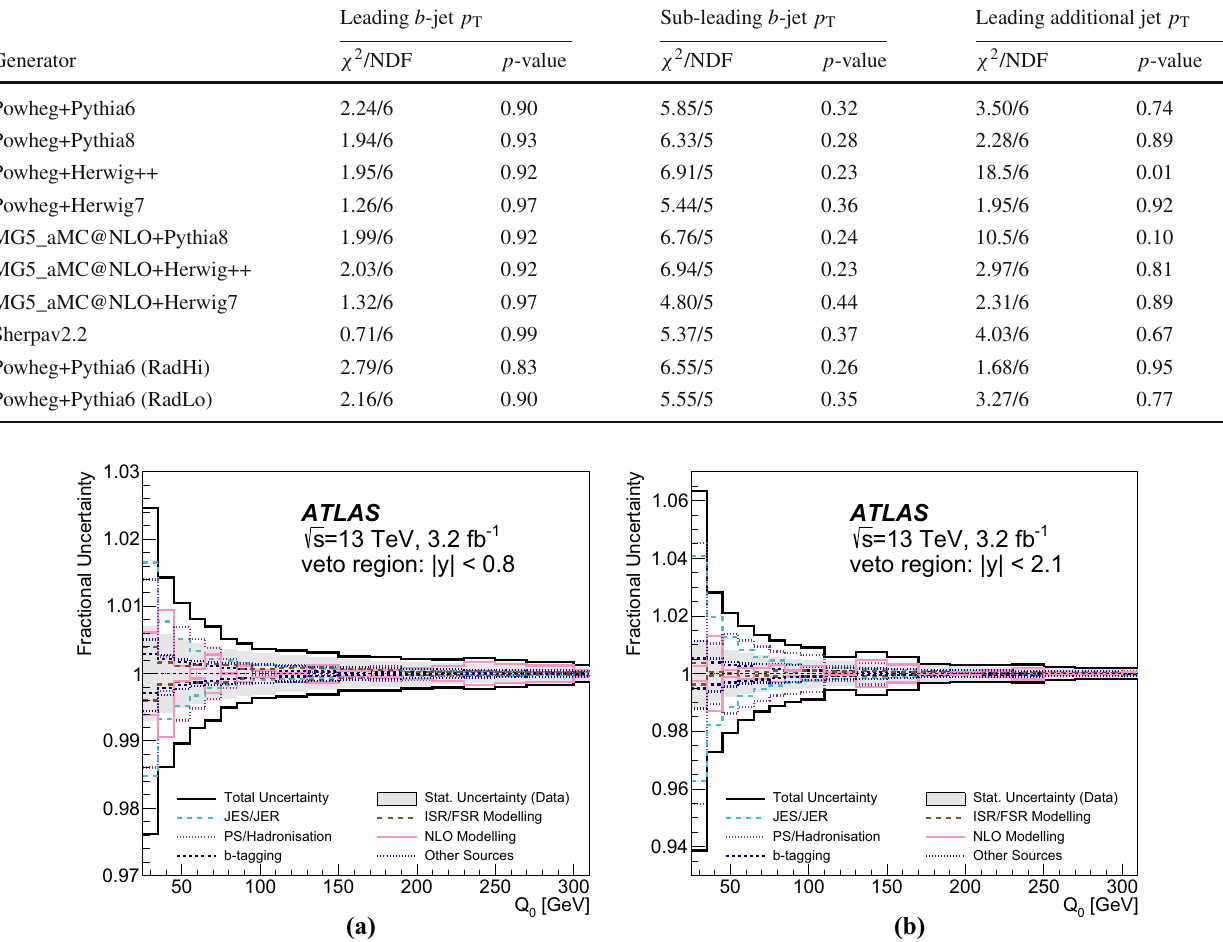
tainty by the solid black line . The systematic uncertainty is shown bro- kendown intoseveral groups, eachofwhich includes various individual components